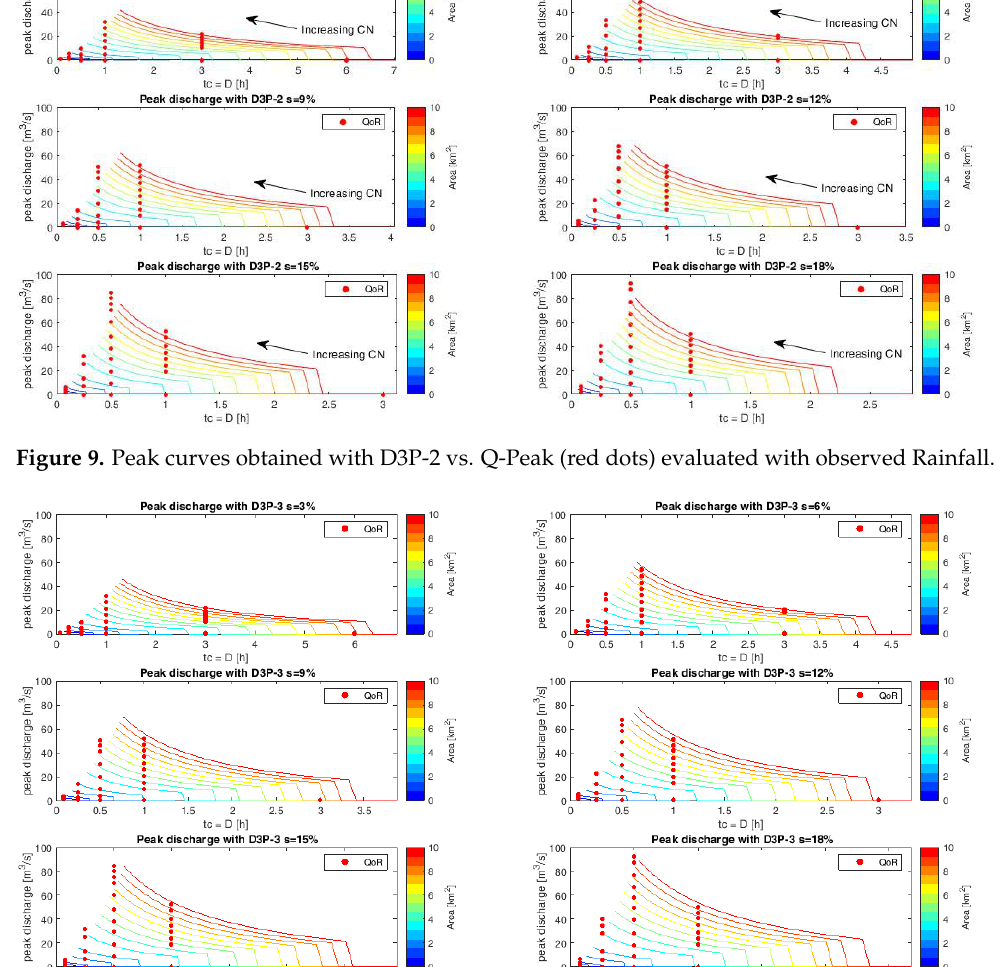
Figure 10. Peak curves obtained with D3P-3 vs. Q-Peak (red dots) evaluated with observed Rain- fall..